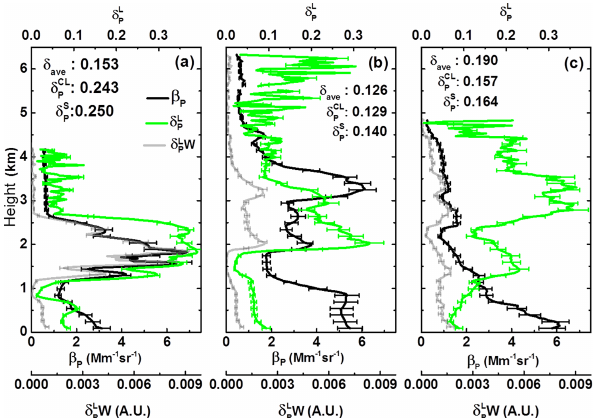
Figure 2. Lidar-derived aerosol backscatter coefficient ( β P ; black line), the linear particle depolarization ratio ( δ L weighted linear particle depolarization ratio ( δ LW observed (a) from 23:00 to 23:15UTC on 13 March 2010, (b) from 06:00 to 06:15UTC on 22 March 2010, and (c) from 23:15 to 23:30UTC on 3 May 2010. The wavelength of δ S height is expressed as altitude above ground level